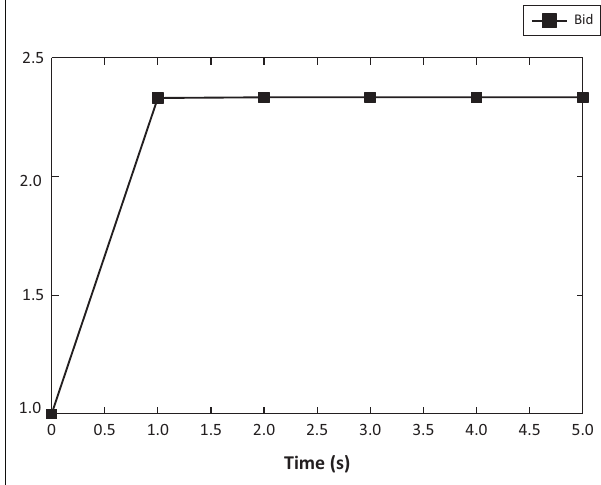
FIGURE 1: Plot of B auction) t ∈ [ t